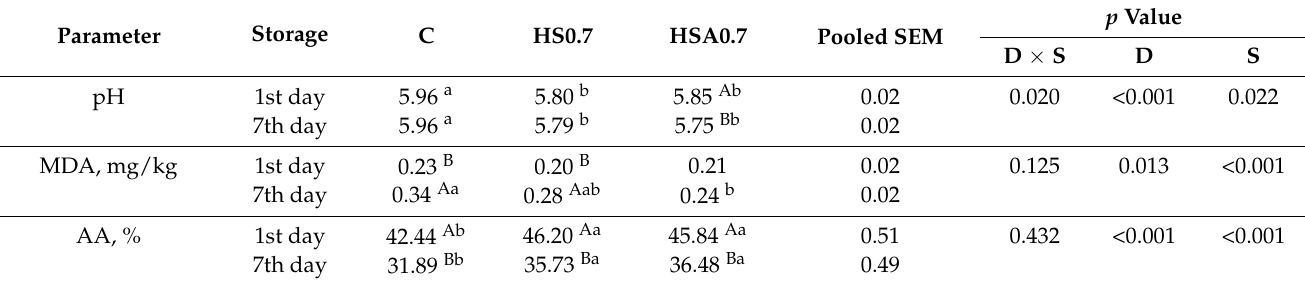
Table 5. The results of pH and malondialdehyde (MDA) content determination in breast meat samples during storage (mg/kg). Parameter